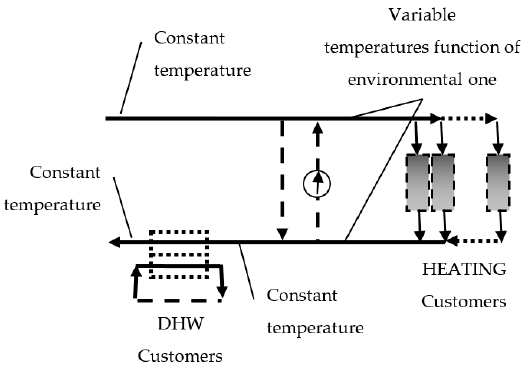
Figure 1. The heating carrier flow, assuring constant heat rates for heating and domestic hot water (DHW).